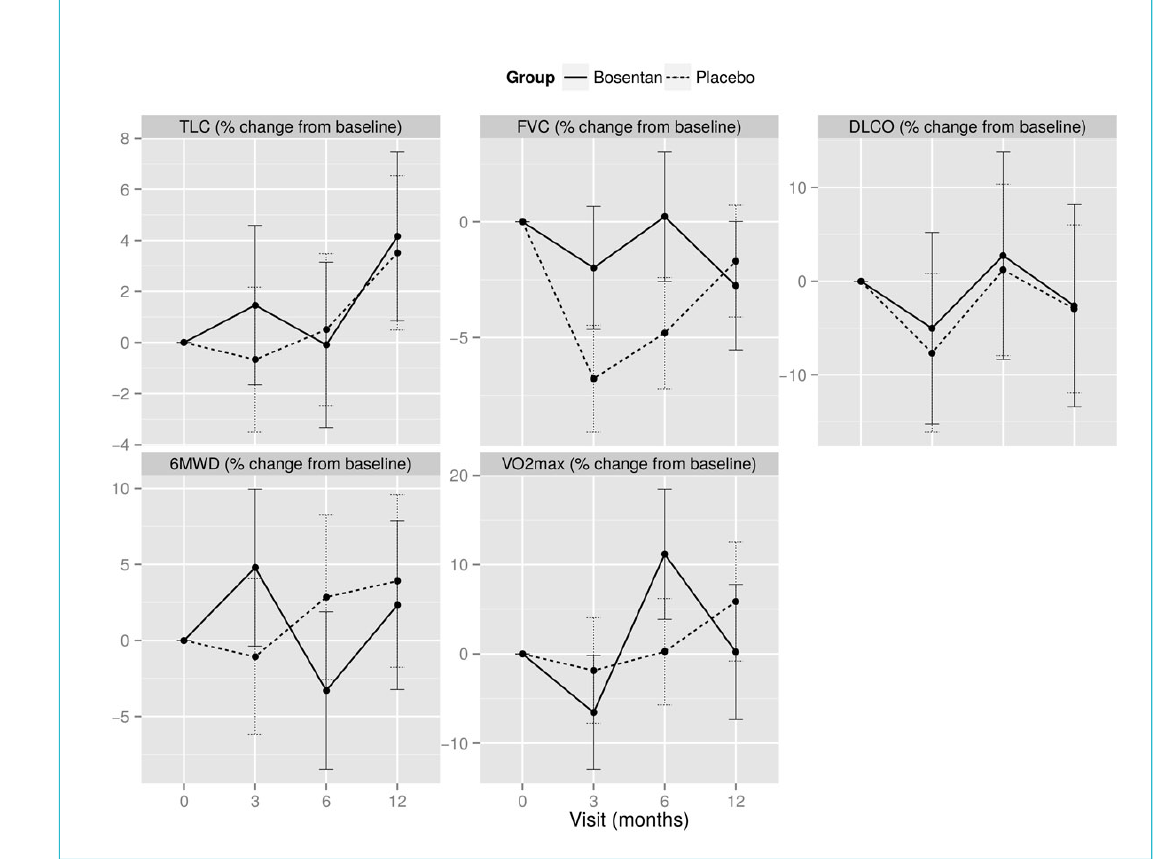
Figure 3: Percent change at baseline and months 3, 6 and 12 for total lung capacity (TLC), forced vital capacity (FVC), diffusion capacity of the lung for carbon monoxide (DLCO), 6-minute walking distance (6MWD), and maximal oxygen uptake (VO 2